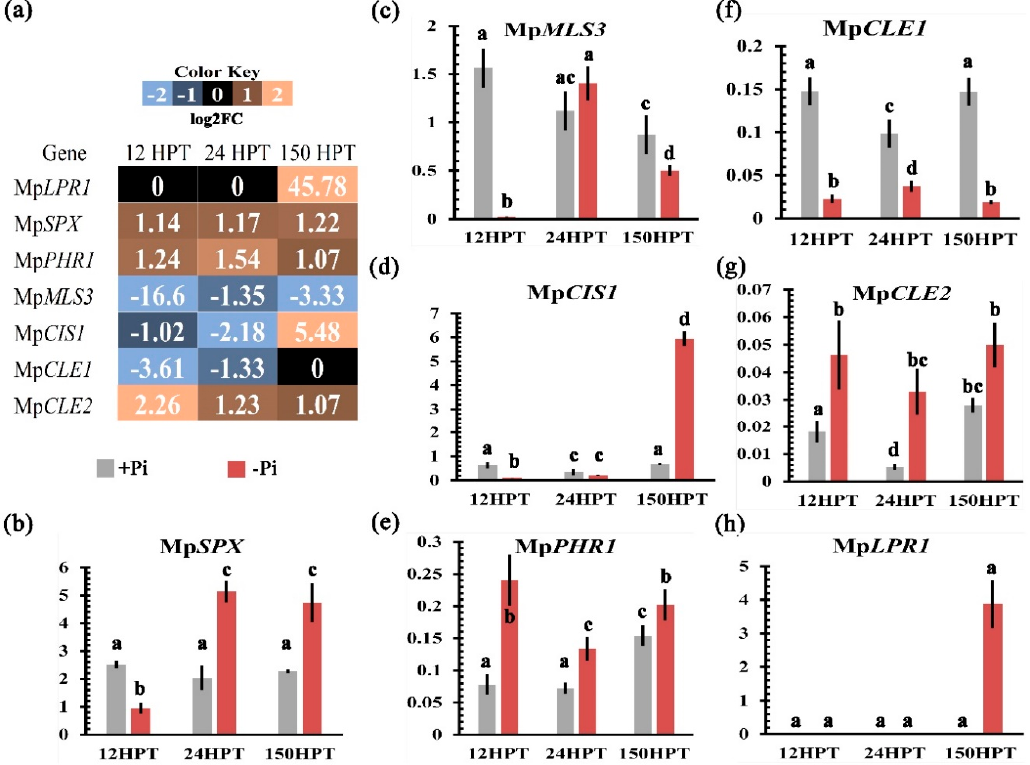
Figure 4. Validation of transcriptome by quantitative real-time qPCR. ( a ) Heat map showed the transcriptional profile of Mp SPX, Mp PHR1, Mp CLE2, Mp LPR1, Mp CIS1, Mp CLE1, and Mp MLS3 ( b – h ) Transcript levels of Mp SPX , Mp PHR1 , Mp CLE2 , Mp LPR1 , Mp CIS1 , Mp CLE1 , and Mp MLS